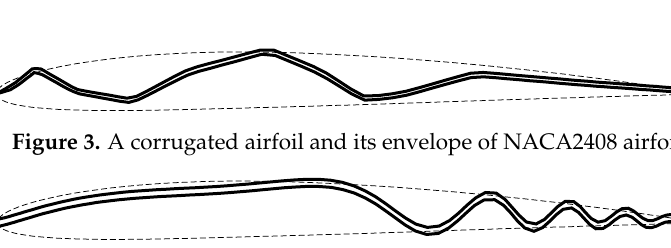
Figure 4. The shape of a wavy airfoil that has an inflection point in the chord direction.